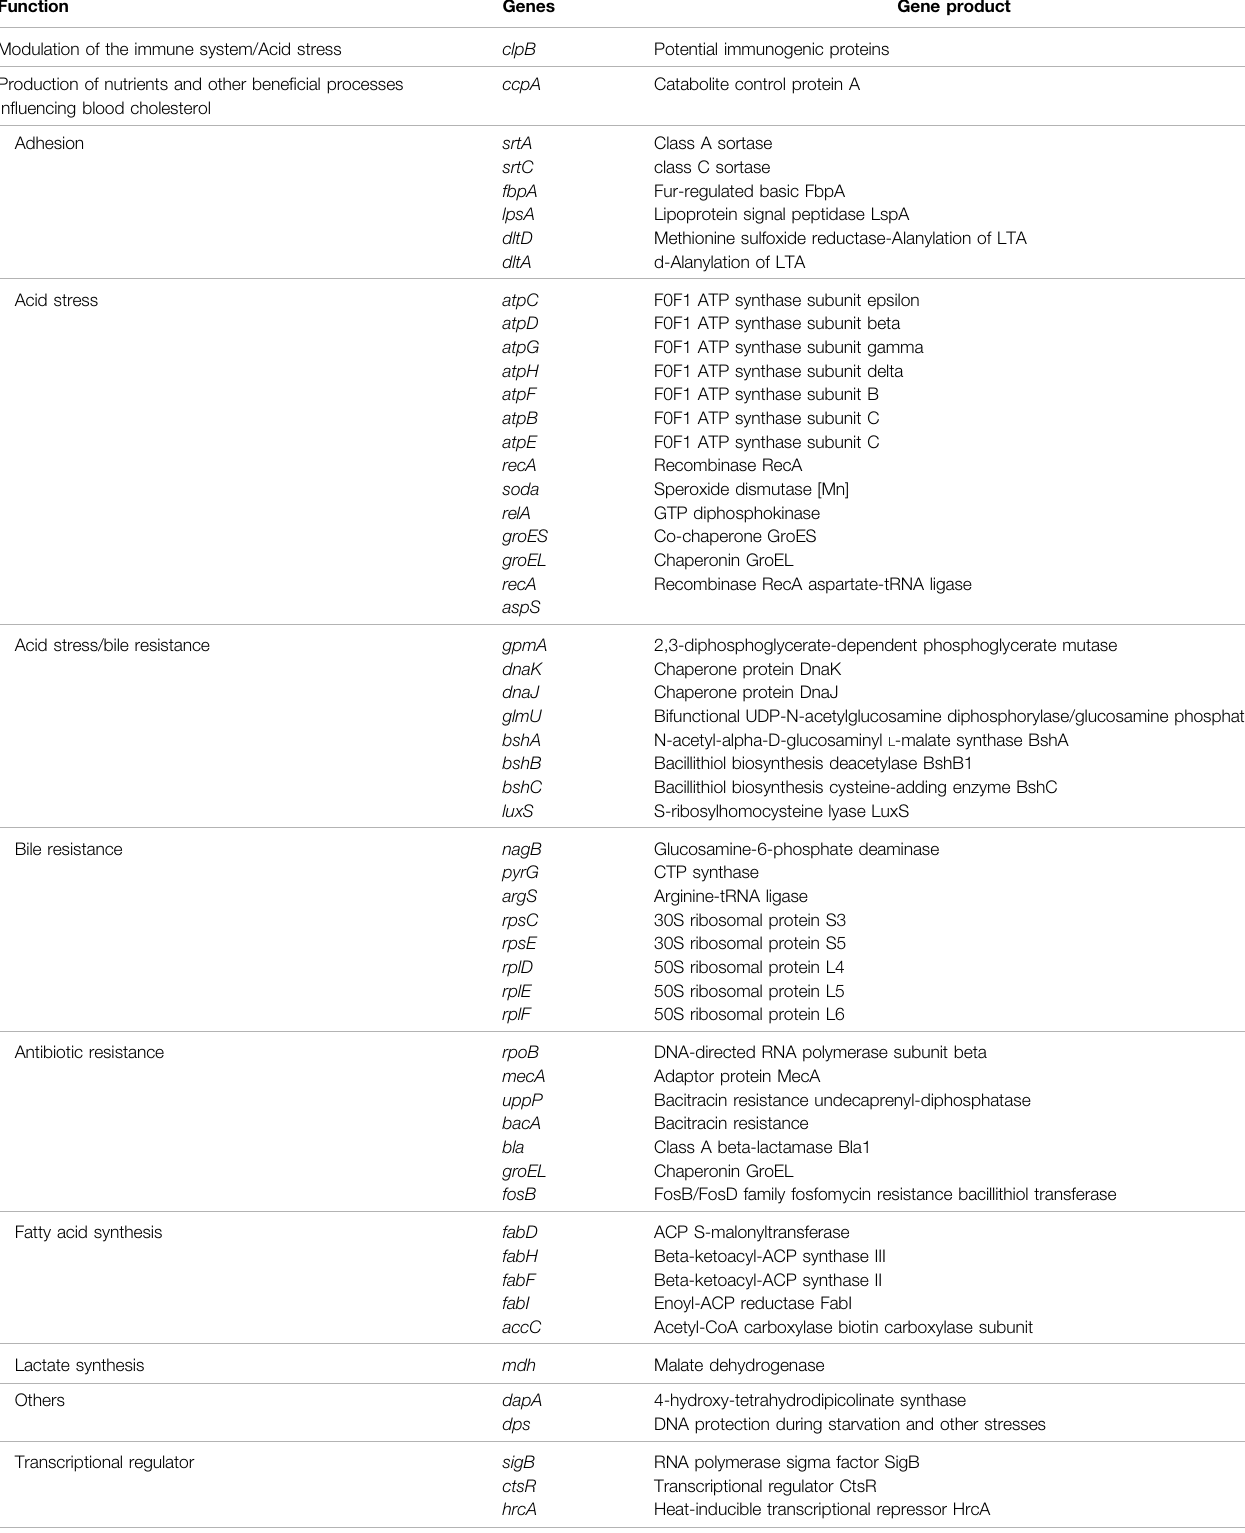
TABLE 1 | Potential genes related to different probiotic properties from Bacillus paranthracis strain MHSD3